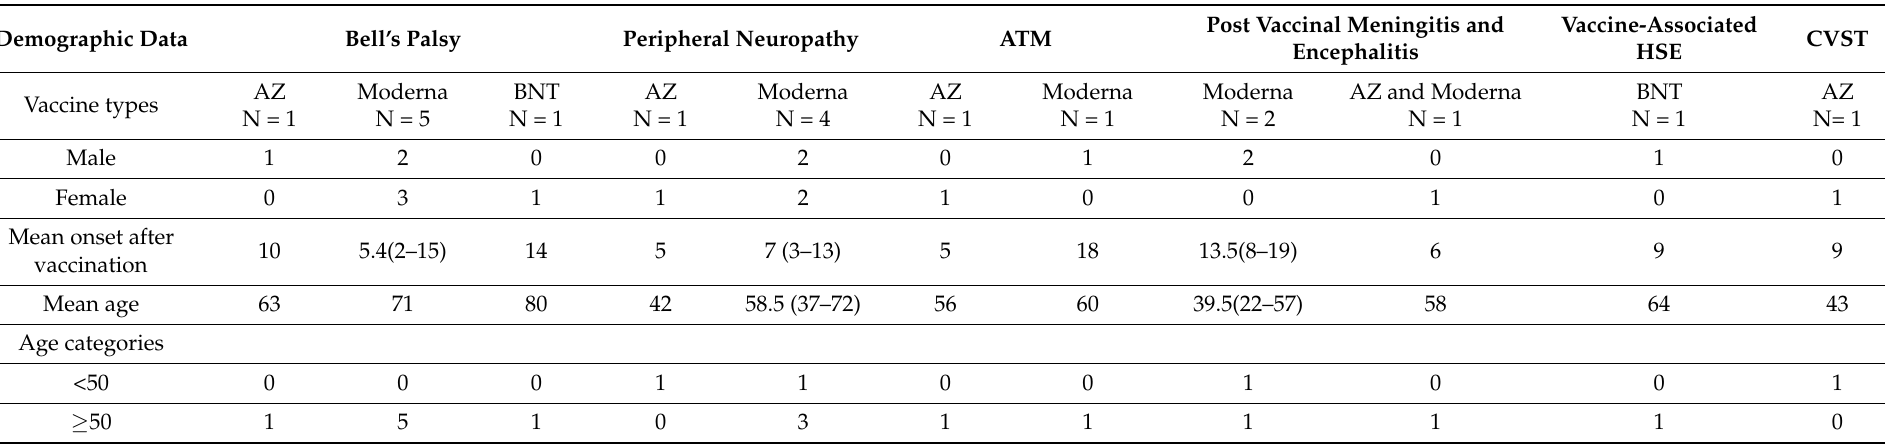
Table 2. Demographic characteristics of patients who had neurological complications following COVID-19 vaccines in